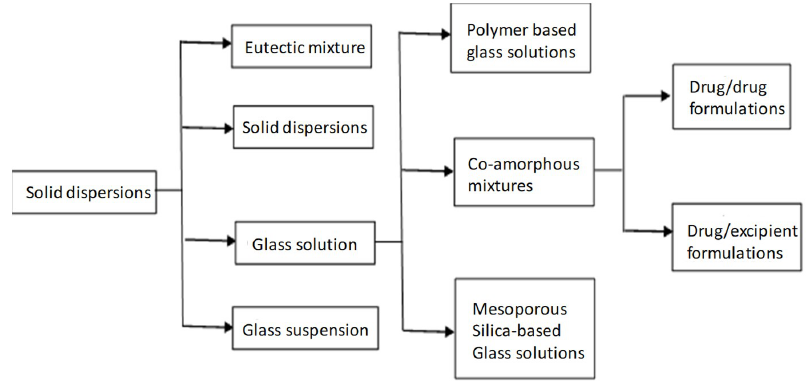
Figure 1. Classification chart of solid dispersions [10].